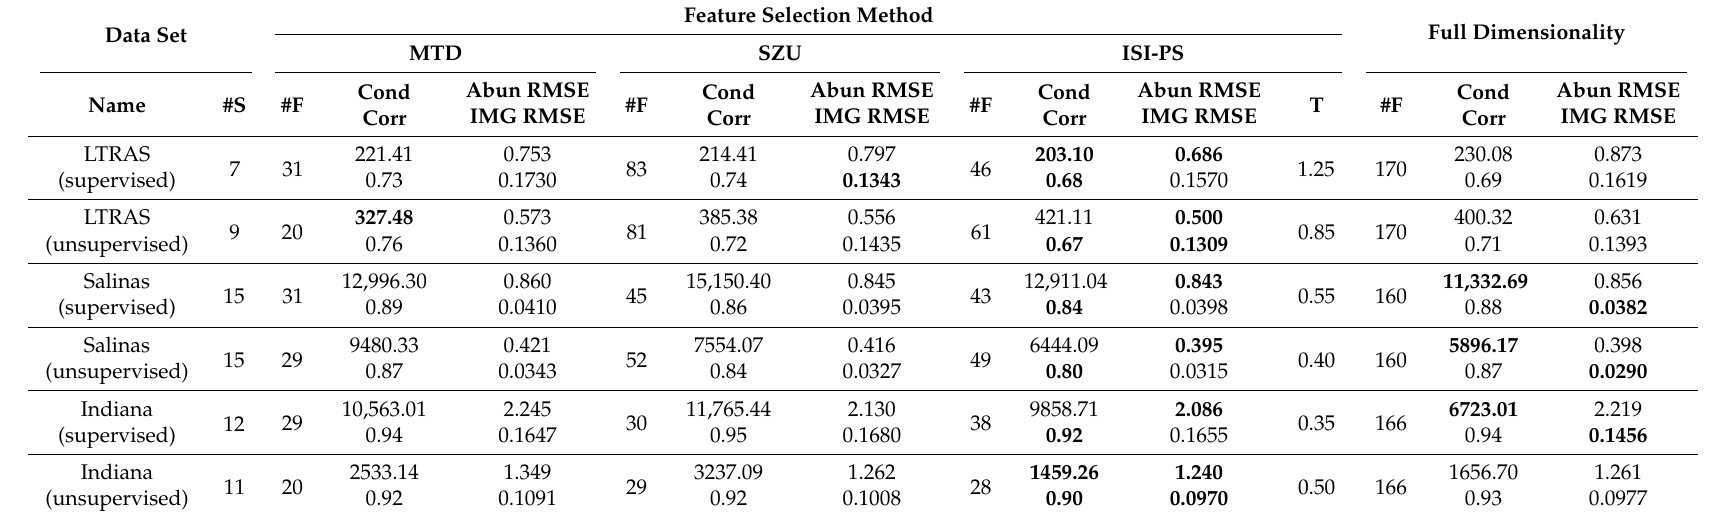
Table 4. The accuracies obtained from the selected bands using the MTD, the SZU, the proposed ISI-PS methods, and the full dimension real hyperspectral datasets to estimate the fractional